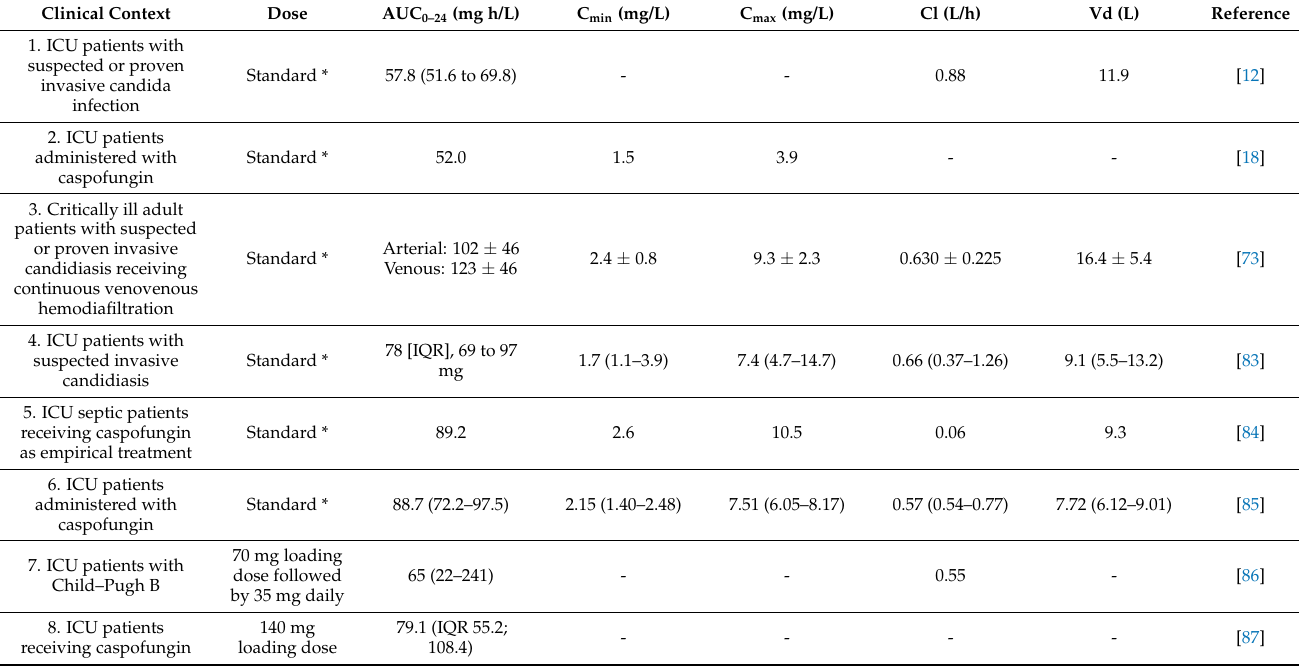
Table 5. Summary of Clinical Studies Assessing PK Parameters of Caspofungin in Critically Ill